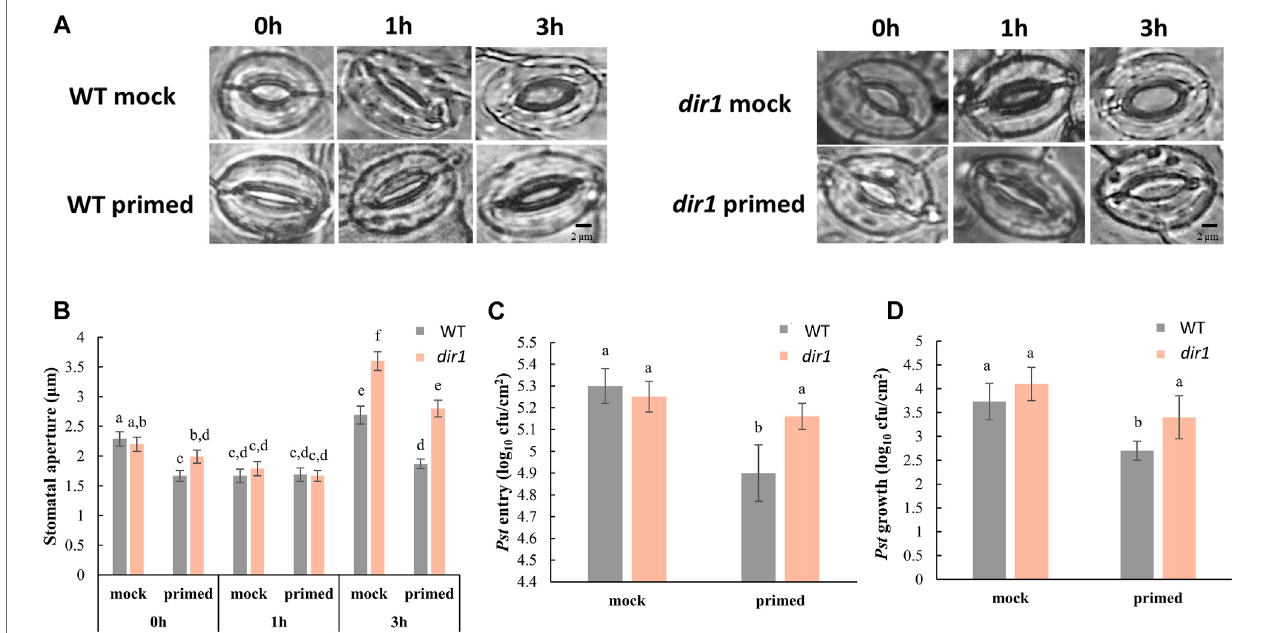
FIGURE 1 | Pathogen entry and growth differences in mock-primed and Pst -primed dir1-1 mutant and wild-type (WT) Arabidopsis leaves. (A) . Images showing representative stomatal apertures in distant leaf of mock-primed and Pst -primed dir1-1 and WT Arabidopsis after 0, 1, and 3 h exposure to Pst DC3000 (please refer to Supplementary Figure S1 for experimental design). (B) . Quantitative measurements of 150 stomata from three independently replicated experiments. Two-way ANOVA and unpaired Student ’ s t-test were conducted. The p -values less than 0.05 were considered statistically signi fi cant. The data were plotted as mean with 95% con fi dence interval for convenient visualization of statistical signi fi cance. Statistically signi fi cant different groups were marked by different letters. (C) . Pst DC 3000 entry results obtained from nine biological replicates of Pst -primed and mock-primed dir1-1 and WT plants obtained from three independently replicated experiments. The data are presented as mean with 95% con fi dence interval. (D) . Pst DC 3000 growth at the 3-day post Pst exposure. The results were obtained from nine biological replicates of Pst -primed and mock-primed plants. The data are presented as mean with 95% con fi dence interval. cfu, colony-forming